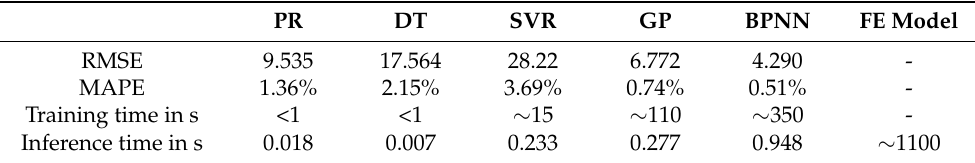
Table 5. Results of the models on the test set for Use Case